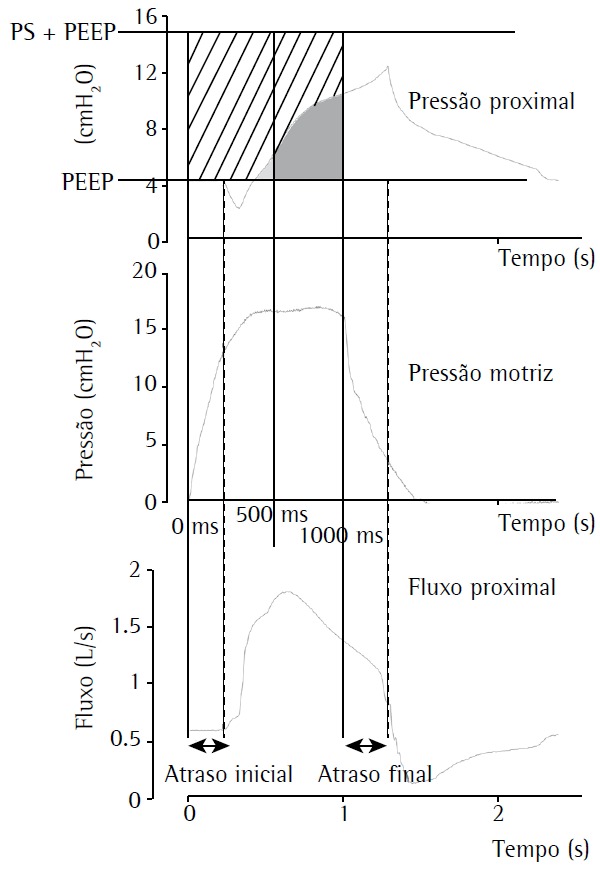
 Representação das variáveis medidas. Traçados de pressão (superior)
e fluxo (inferior) de uma medida hipotética com positive end-expiratory
pressure (PEEP, pressão expiratória final positiva) de 5 cmH2O e pressão
de suporte (PS) de 10cmH2O. No meio, traçado da pressão para o ventilador
drive. O traçado superior mostra o produto da pressão e tempo
inspiratórios a 500 ms (PPT500; área cinza claro) e a 1 s (PPTt; área
cinza escuro mais área cinza claro), ambos expressos em porcentagem de
área ideal (áreas hachuradas).